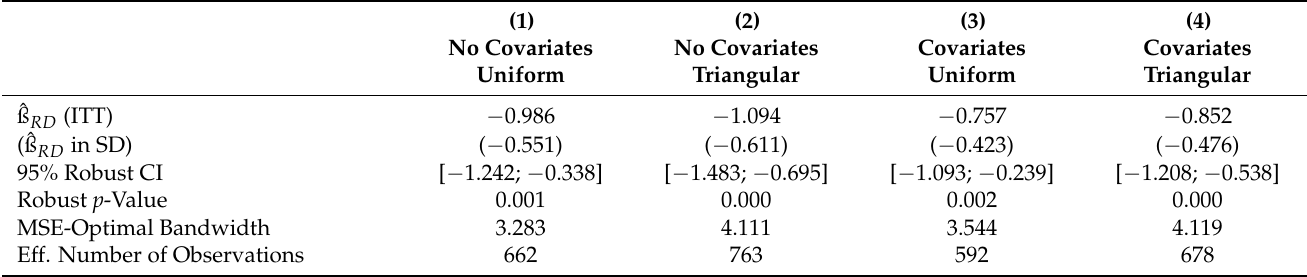
Table 2. RD effect of lockdown on life